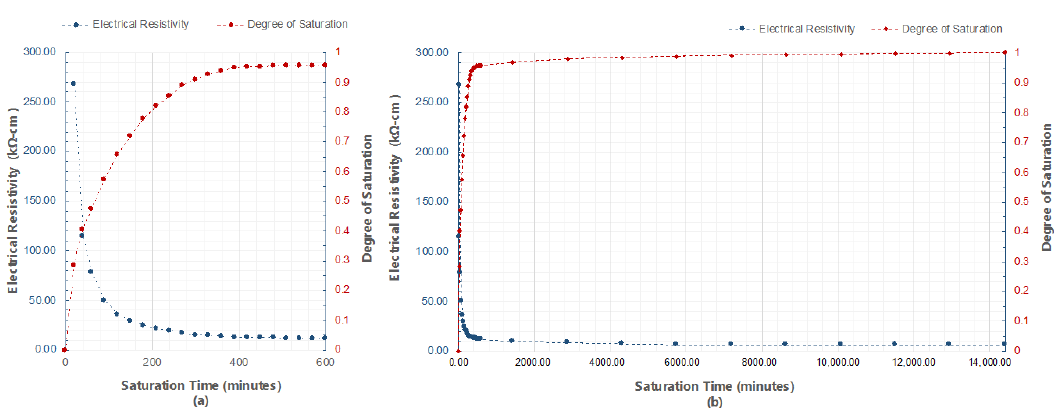
Figure 13. Relationship between electrical resistivity (ER) and degree of saturation with respect to saturation time of ( a ) 600 min, and ( b ) 14,400 min (10